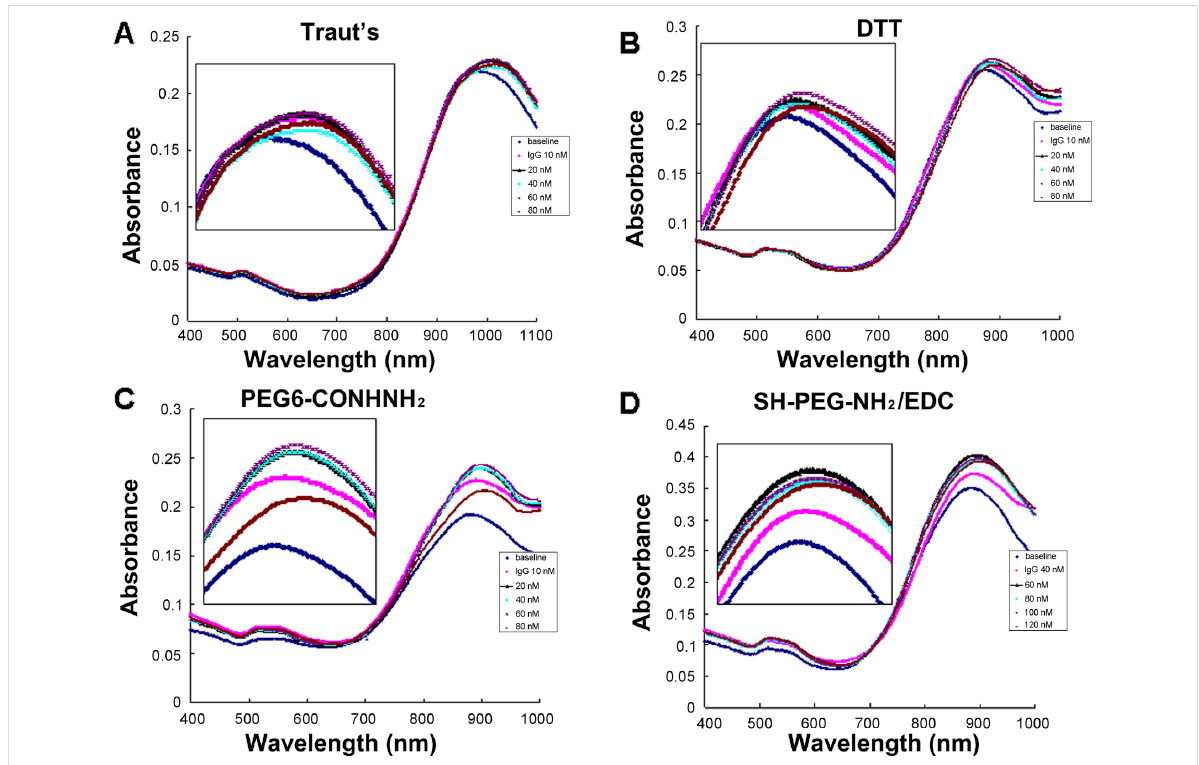
Figure 5: Absorption spectra before and after probing the varying concentrations of human IgG by the functionalized GNR biochip using (A) Traut’s reagent, (B) DTT, (C) PEG6-CONHNH 2 , and (D) SH-PEG-NH 2 combined with EDC reaction to introduce thiol groups to anti-IgG.